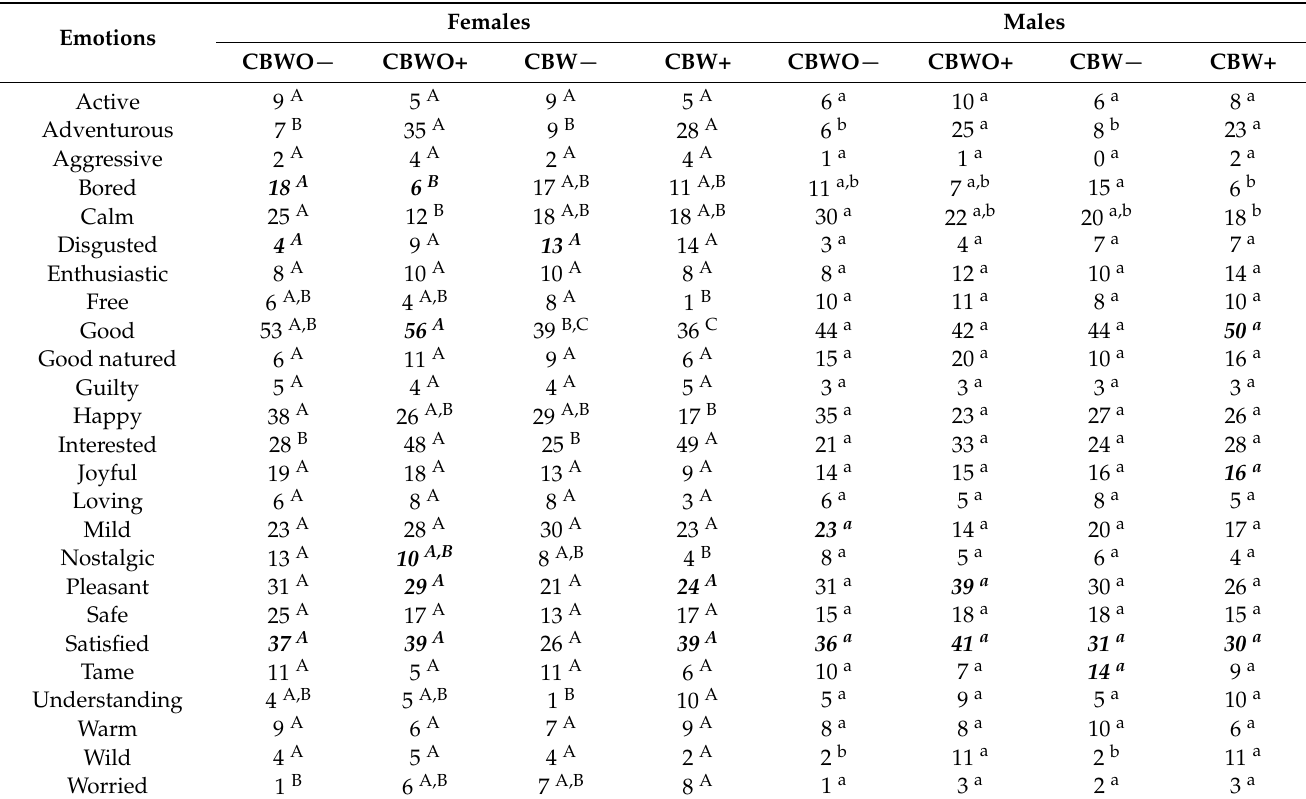
Table 4. Emotional profile † elicited by treatments ‡ in the after-tasting